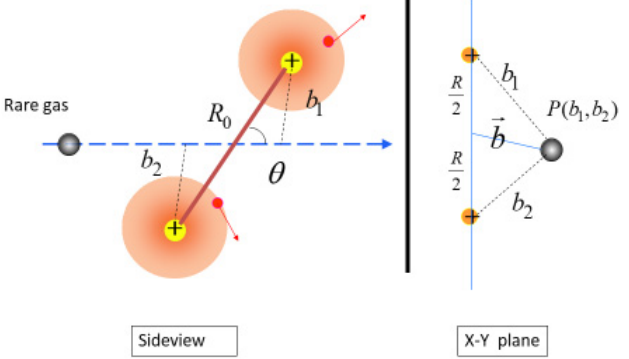
Figure 1. Schematic side ( y - z plane) view and x - y plane view of two atom cluster colliding with a rare gas atom projectile.